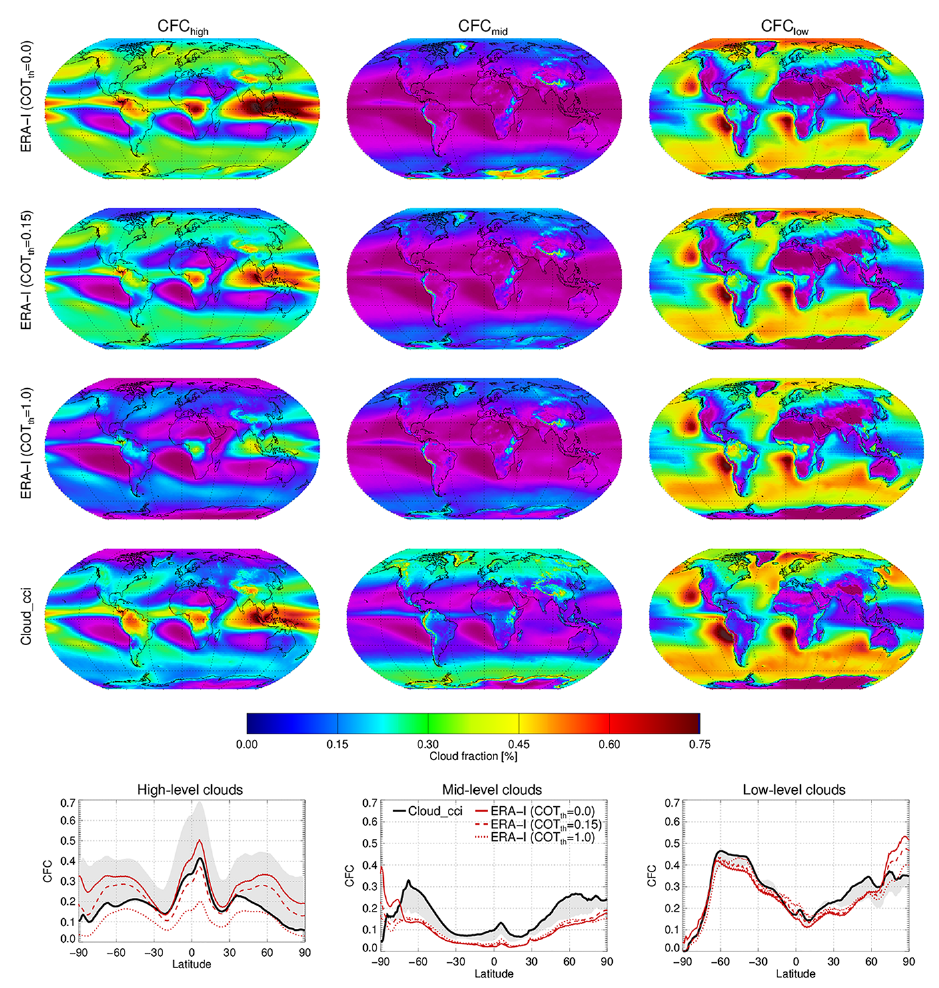
Figure 4. Multi-annual mean cloud fraction from ERA-Interim (rows 1–3) and Cloud_cci (row 4) for high-level (CFC high , left column), mid- level (CFC mid , middle column) and low-level clouds (CFC low , right column). The ERA-Interim cloud fraction was produced by SIMFERA for three optical thickness thresholds (COT th = 0 . 0, 0.15, 1.0; rows 1 to 3, respectively). Bottom row: zonal mean plots with grey shaded areas showing the estimated uncertainty in Cloud_cci CFC high , CFC mid and CFC low based on comparisons to CALIOP.